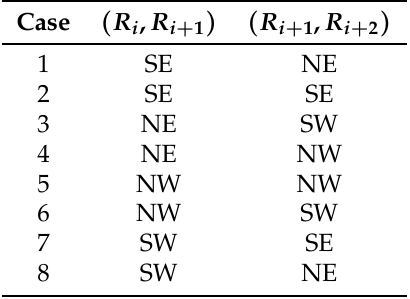
Table 4. Examples of the inner corner